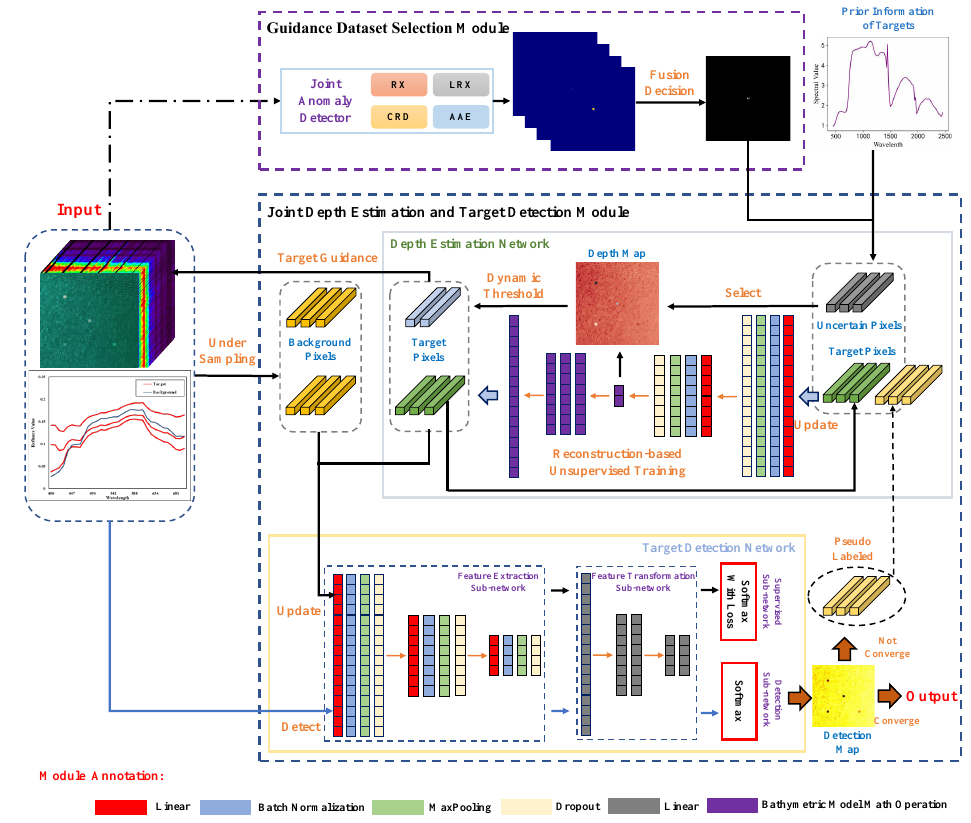
Figure 2. The general framework of our proposed method. Guidance dataset selection module is the initial part of SUTDF, which devotes to creating the guidance dataset for the JDETD module. According to Figure 2, the depth estimation network requires to be trained with the pixels containing targets of